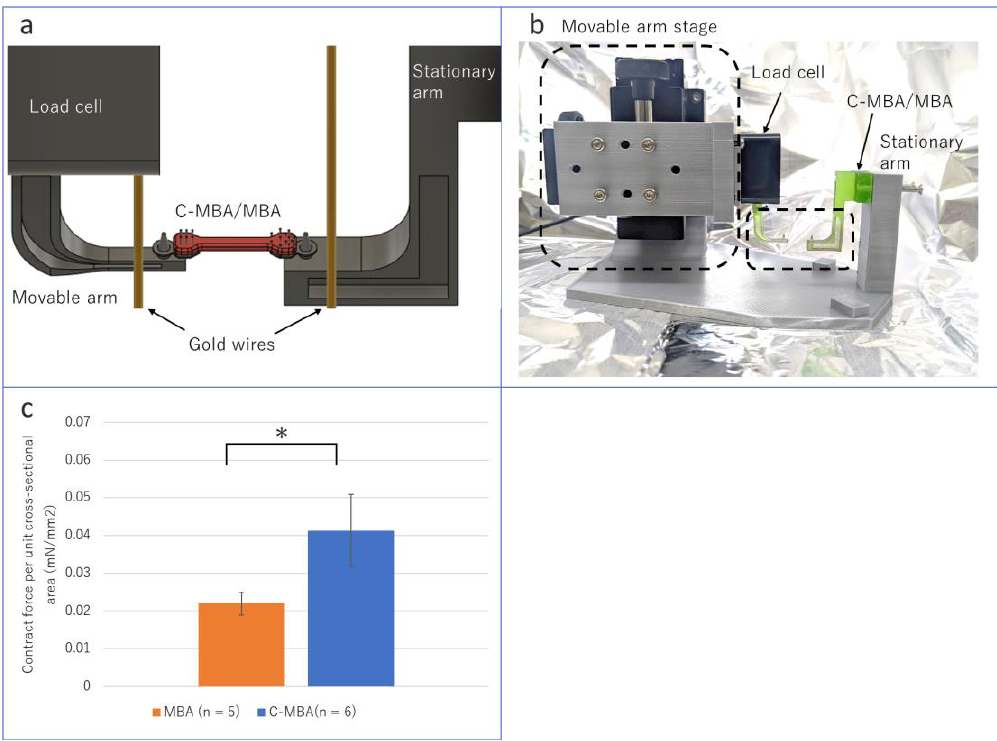
Figure 5. MBA contraction force measurement system: ( a ) measurement system overview, ( b ) actual fabricated measurement system, ( c ) increased contraction force per unit cross-sectional area with C-MBA. Asterisks indicate comparable groups and statistical significance (* p < 0.05).